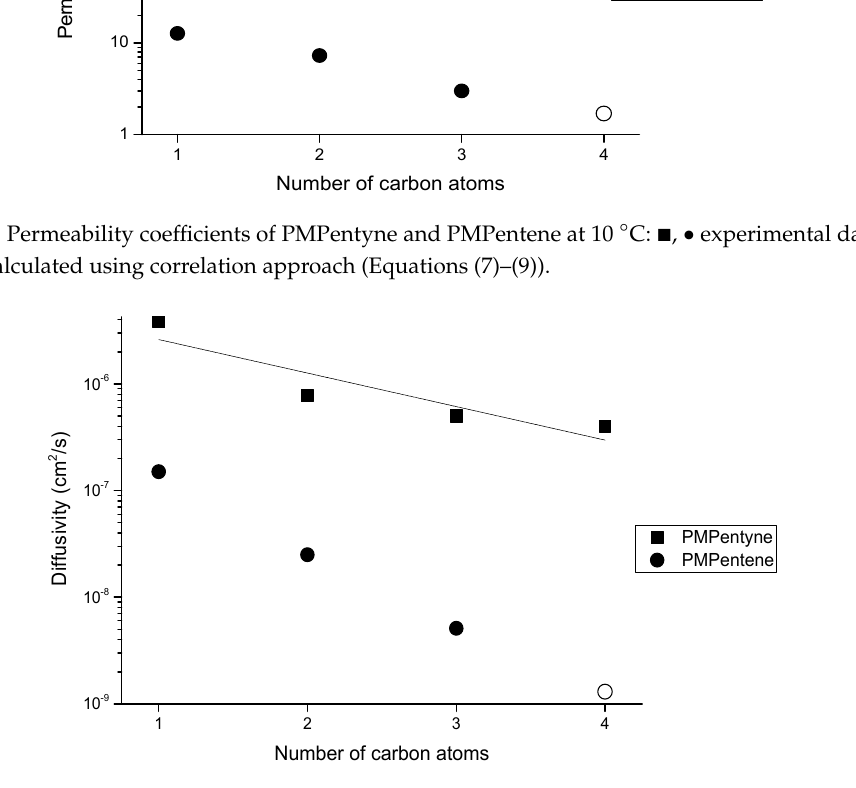
Figure 5. Di ff usion coe ffi cients of PMPentyne and PMPentene at 10 ◦ C: (cid:4) data calculated from D = P / S , • experimental data; (cid:35) calculated using correlation approach (Equations (7)–(9)).